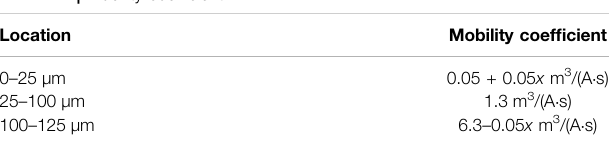
TABLE 2 | Mobility coef fi cient.